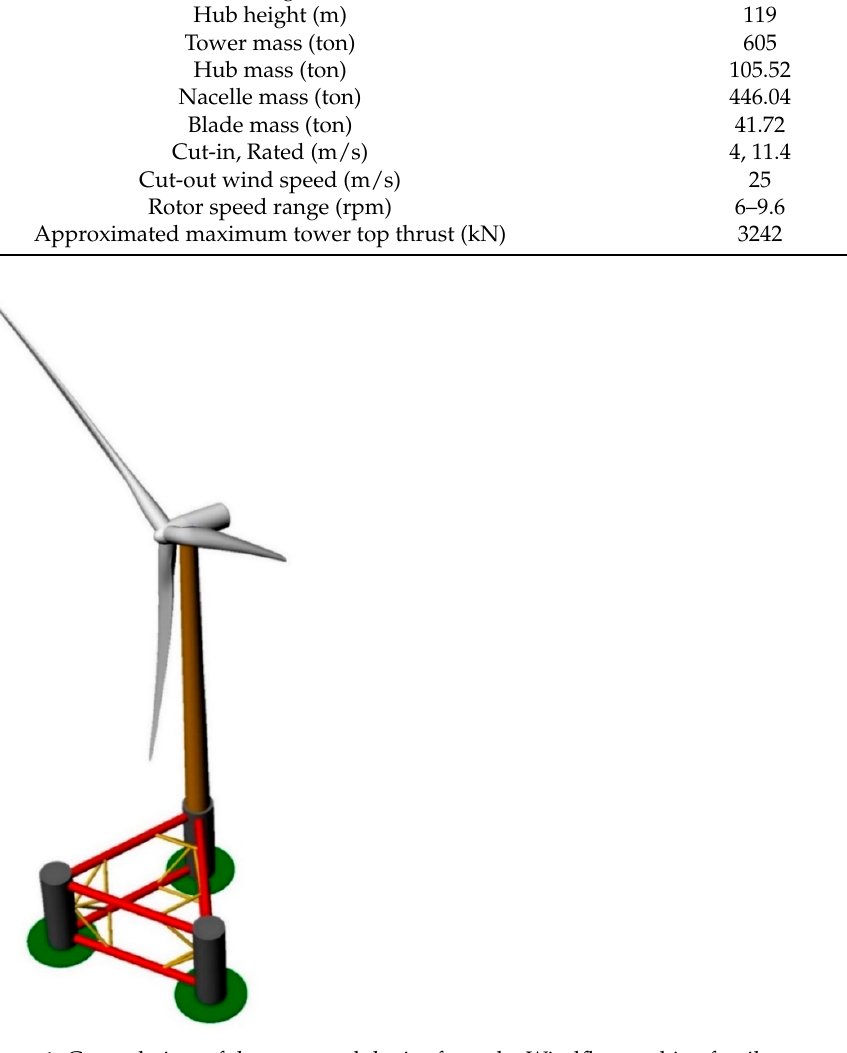
Figure 1. General view of the proposed device from the Windfloat turbine family.